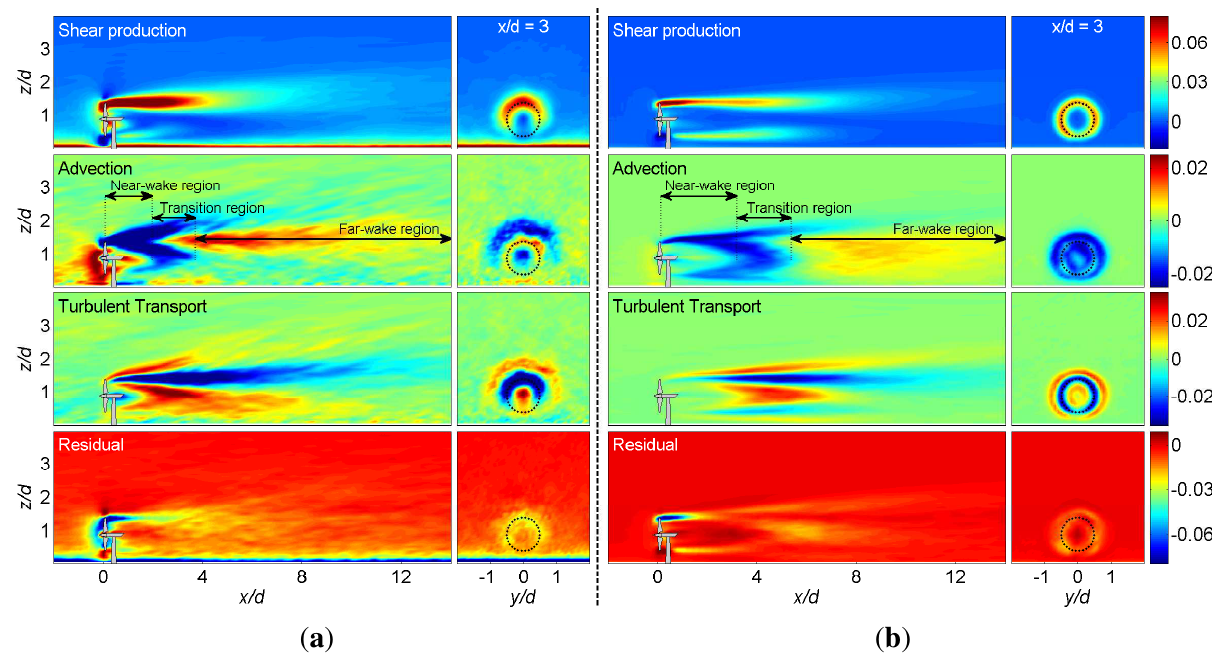
Figure 17. Contours of the TKE budget terms (advection, shear production, turbulent transport, and residual) for the stand-alone turbines installed over flat surfaces with the two different roughness lengths: z = 0.5 m ( a panel) and z = 0.00005 m ( b panel). All the o o /δ = 1.458 m 2 s − 3 quantities are normalized by u 3 hub